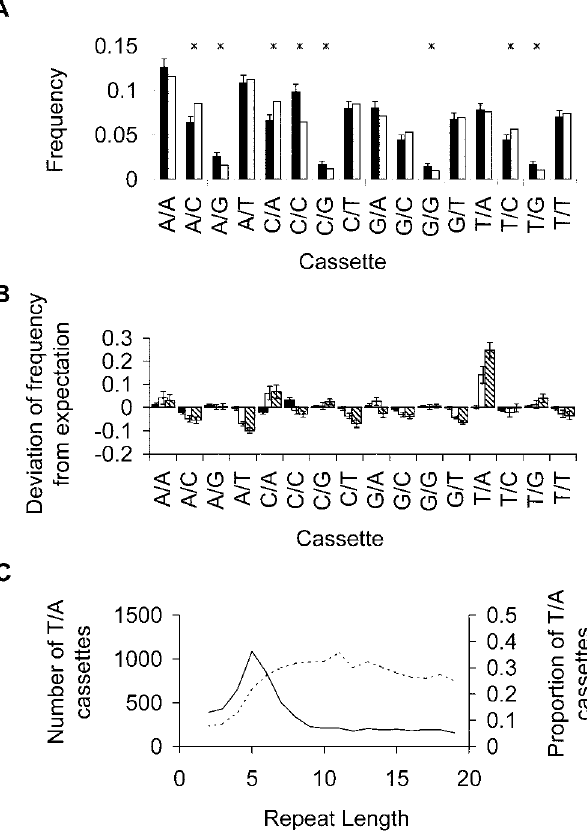
Figure 2. Frequency Distribution of the 16 Possible Microsatellite- Flanking 5 9 –3 9 Base Combinations Relative to Random Expectation (A) Cassette frequencies around (AC) 2 microsatellites: black bars, observed; white bars, expected. Error bars show 95% confidence intervals and asterisks indicate significant difference ( v 2 tests, 1 d.f. p , 0.05 with sequential Bonferroni corrections). (B) Deviation of cassette frequencies from random expectations around (AC) 2 , (AC) 5 , and (AC) 10 microsatellites: black, white, and hatched bars, respectively. (C) Sampled number (solid line) and proportion (dotted line) of microsatellites with cassette T/A as a function of microsatellite length. DOI: